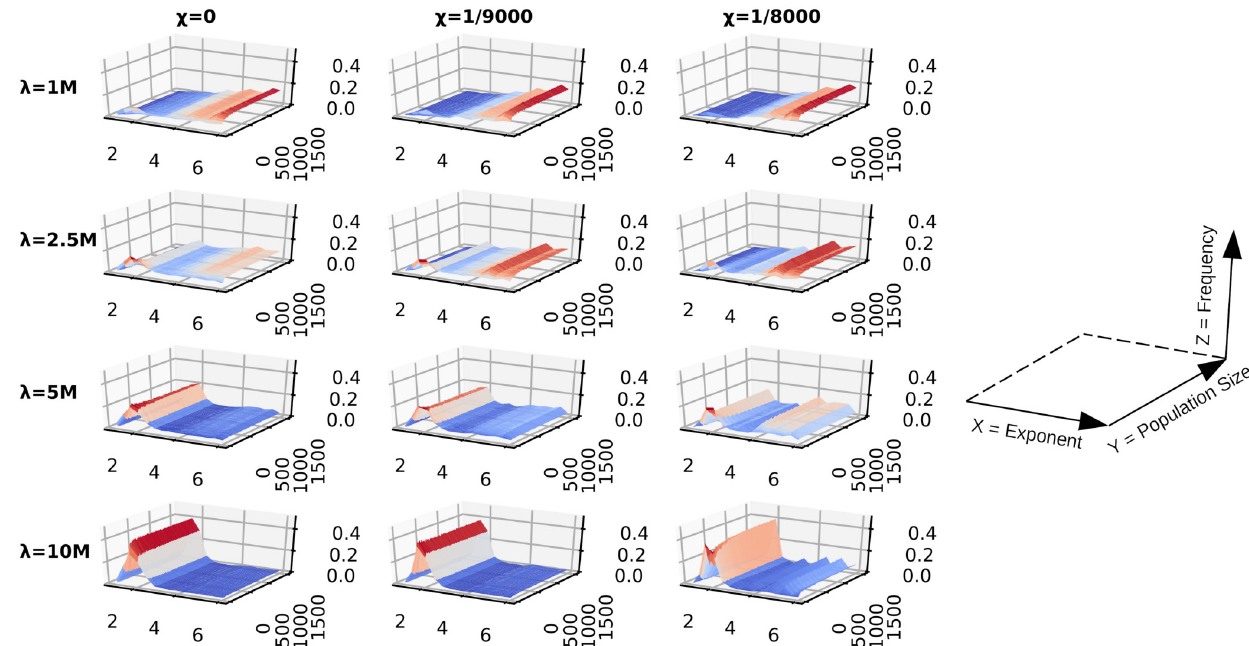
Fig 8. DO fitness landscape with random uniform resources. A matrix of surface plots of the top 1% performing DOs from sub-populations of the single- generation simulations which traversed random uniform environments. Fitness is determined by the average energy over a lifespan, � are indexed by lifespan λ , and the columns by the searching cost χ . A reference plot has been provided in order to interpret the axes of the individual surface plots; the x-axis is foraging exponent, the y-axis is population size, and the z-axis is frequency normalized to [0, 1].